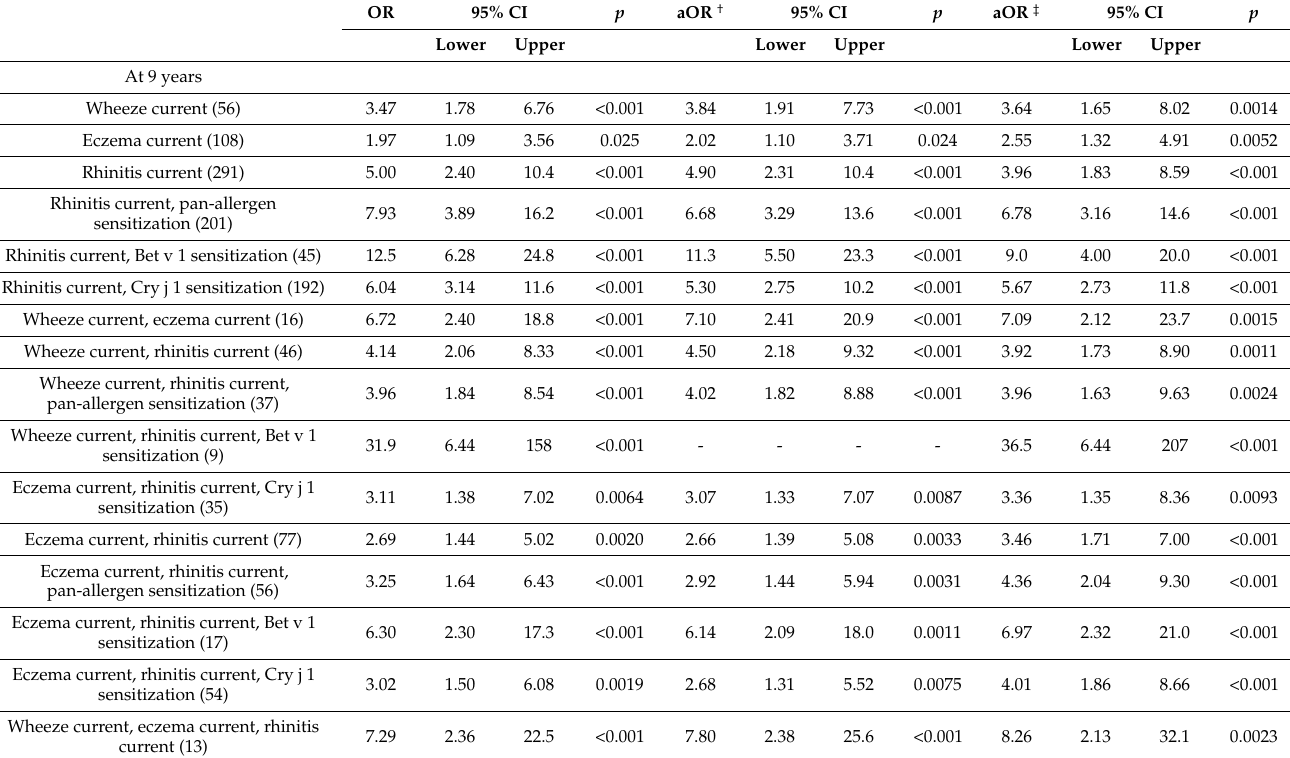
Table 3. Association between allergic diseases at 9 years and PFAS at 13 years of